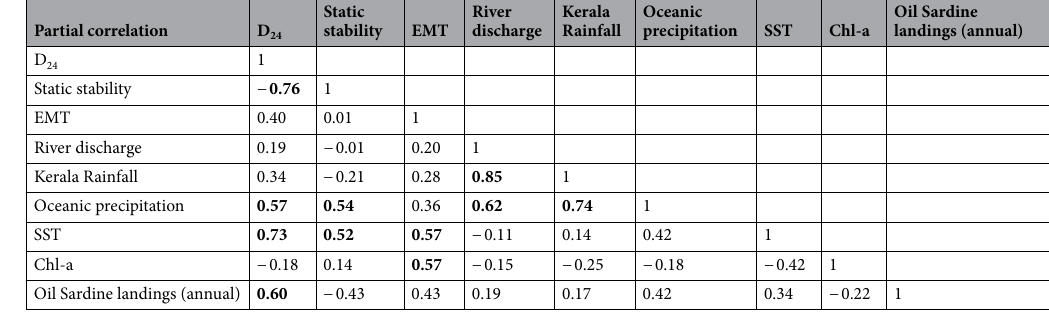
Table 3. Partial correlation among nine variables viz. D 24 , static stability, EMT, river discharge, Kerala rainfall, oceanic precipitation, SST, Chl-a and oil sardine landings. All parameters were average during June to September over the boxes from 8 to 12° N. Valued > 0.5 is bold faced.